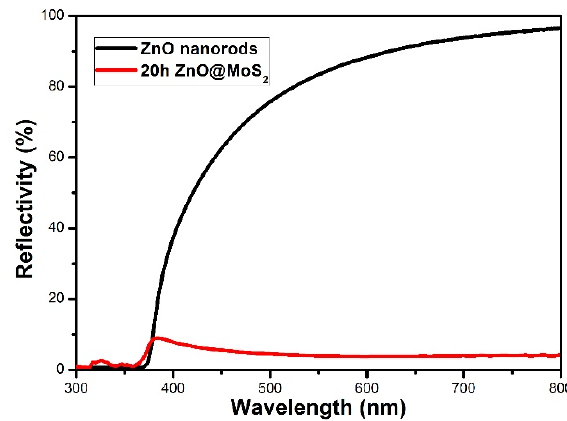
Figure 8. Reflection spectrum of 20 h ZnO@MoS 2 and ZnO nanorods.